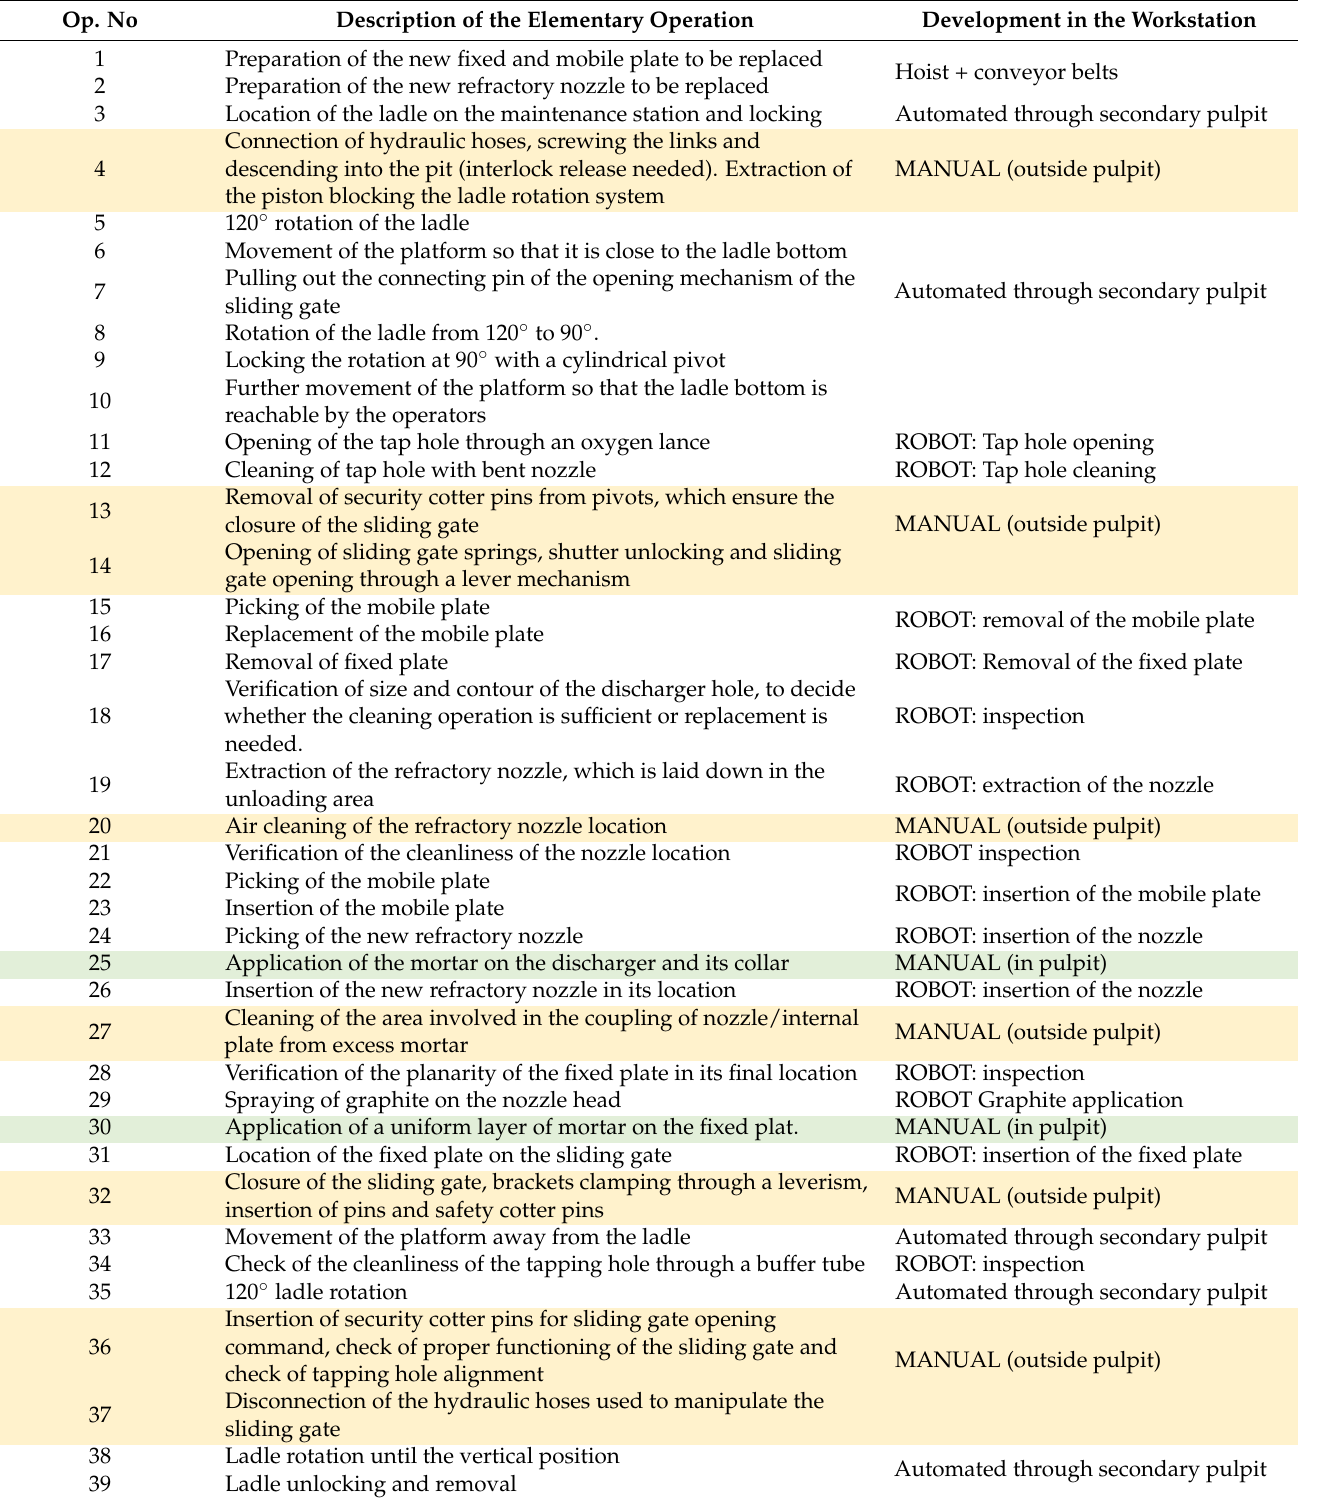
Table 1. List of elementary operations composing the maintenance of the ladle sliding gate and how they are handled in the robotic workstation. For operations which are developed through the robot, the corresponding macro-operation is provided in the third column. The operations which remain manual after the installation of the robotic cell and are developed outside the pulpit are highlighted in yellow. Manual operations developed inside the pulpit are highlighted in